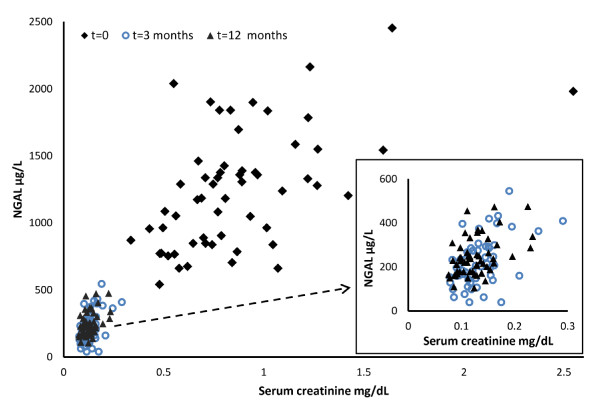
Relationship between serum creatinine and plasma NGAL levels in the kidney allograft recipients. Squares: before transplantation, circles: three months after transplantation, triangles: 12 months after transplantation. Insert: Three and 12 months after transplantation with expanded resolution.